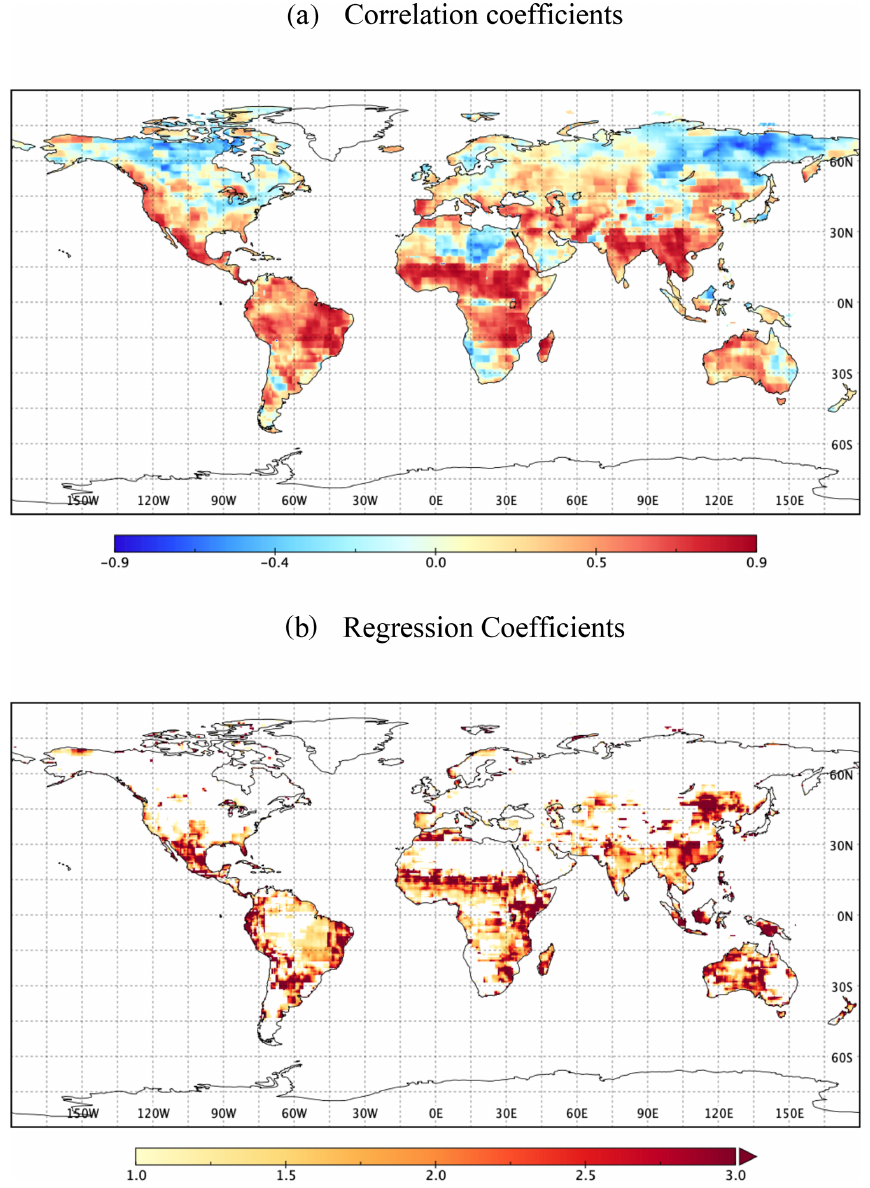
Figure 2. (a) Correlation coefficients and (b) regression coefficients between cumulative detrended precipitation anomalies (cdPA) and the detrended terrestrial water storage anomaly